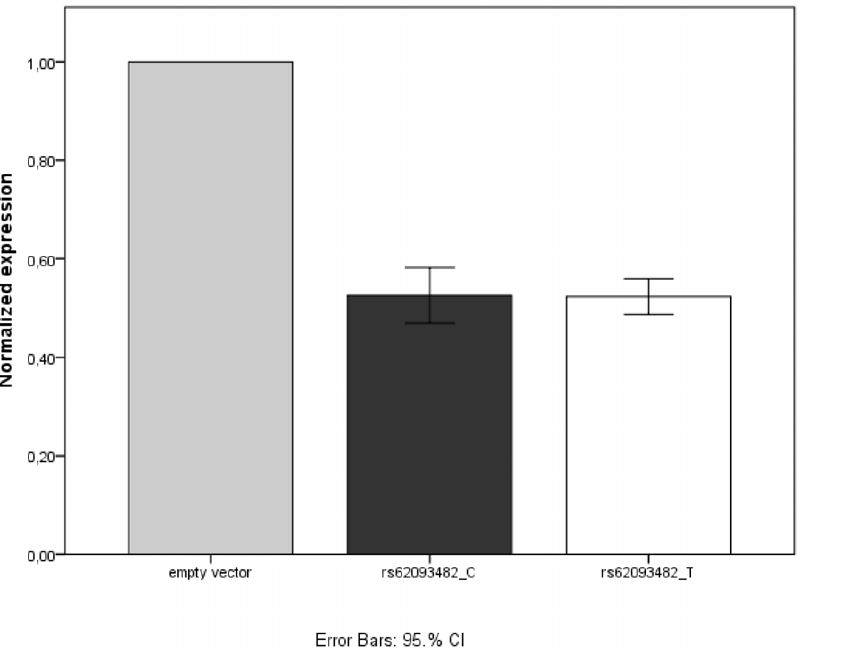
Figure 3. Luciferase activity in a HepG2 cell line transfected with either of the constructs (pmirGLO-TTR-3 9 UTR–C/T for rs62093482). Luciferase activity was measured after 40 h, and normalized to a transfected empty vector. Data are presented as the mean of 20 measures 6 CI. No difference between the two constructs was seen.